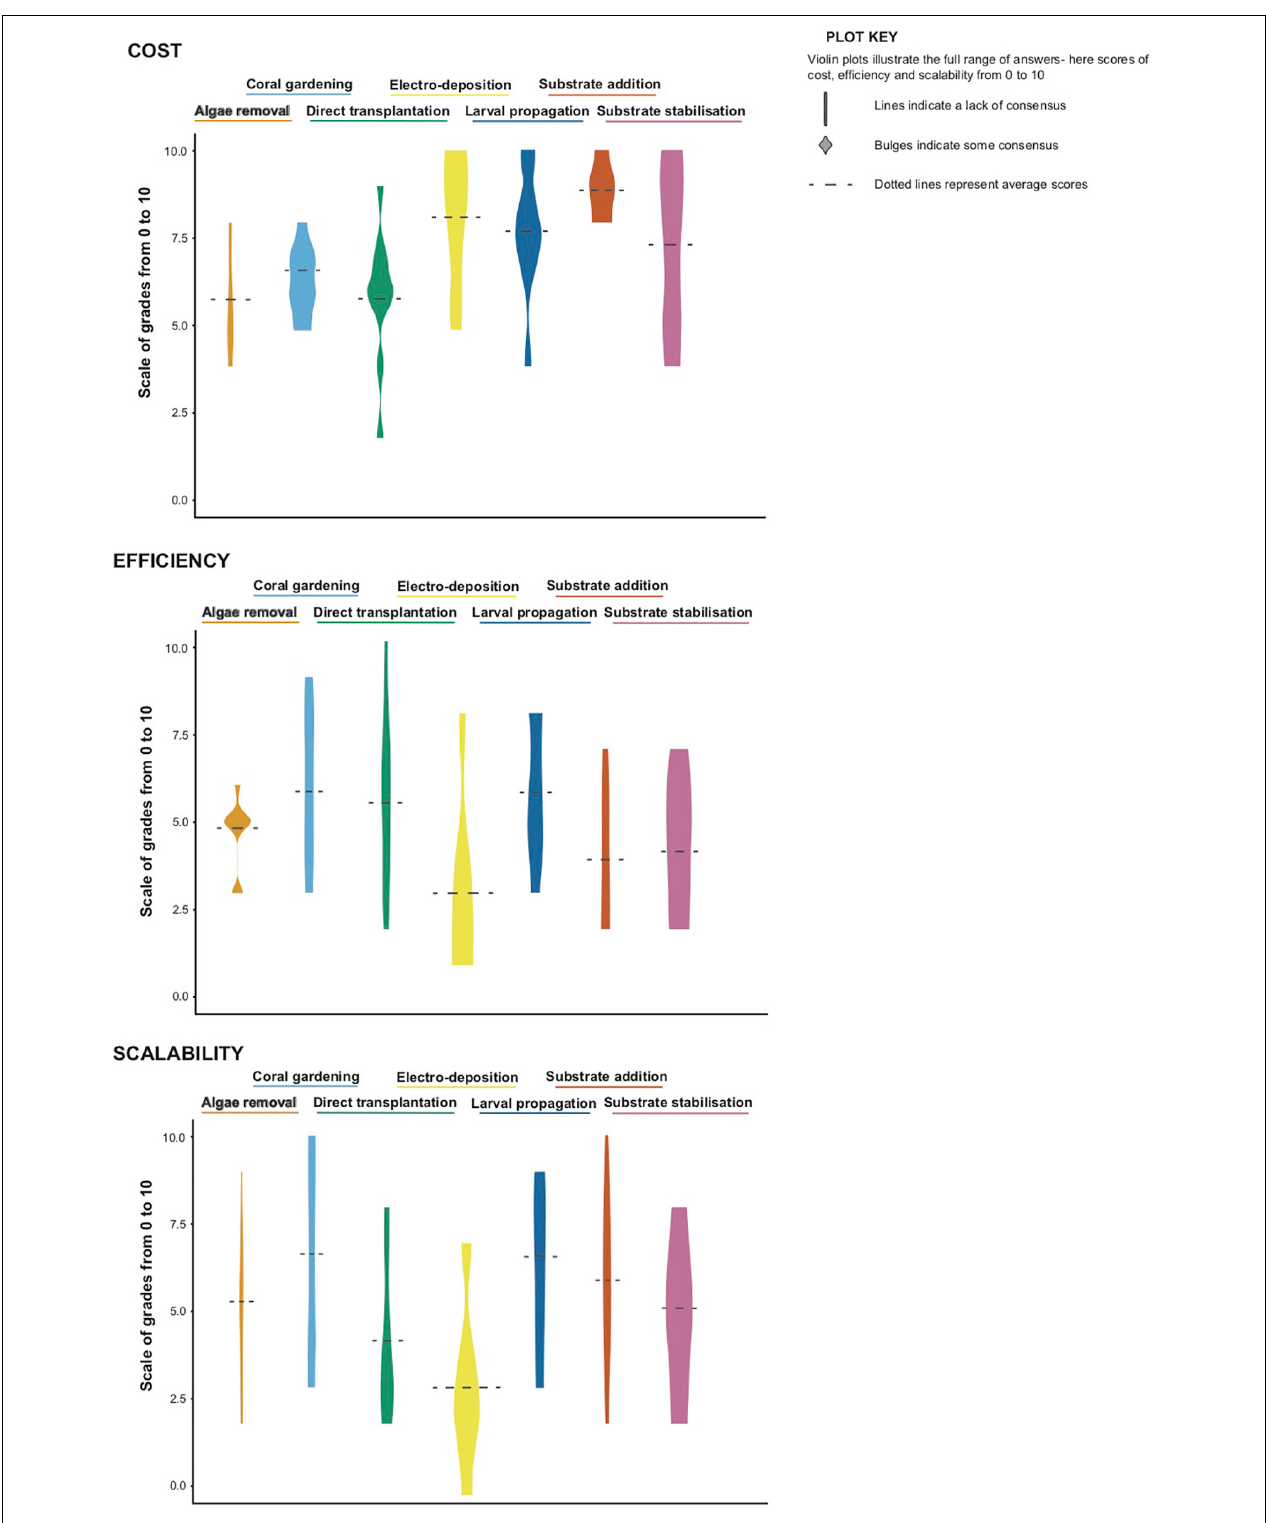
FIGURE 3 | Violin plots representing cost, effectiveness, and scalability of seven common coral reef restoration methods, graded on a scale of 0–10 by n = 11 global experts